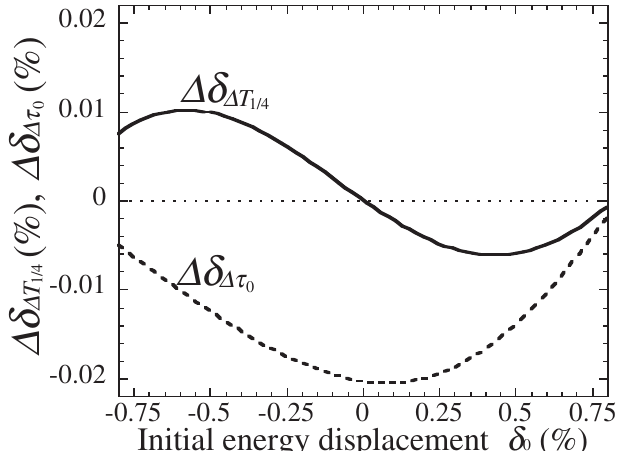
FIG. 11. Calculated contributions of the nonlinear error effects . The solid line shows (cid:1) (cid:3) , the contribution due to in (cid:3) 0 (cid:1) T 1 = 4 , as given by Eq. (B3). The broken line shows variation of T 1 = 4 the contribution due to the initial bunch length (cid:1) (cid:3) as given by (cid:1) (cid:1) 0 Eq.